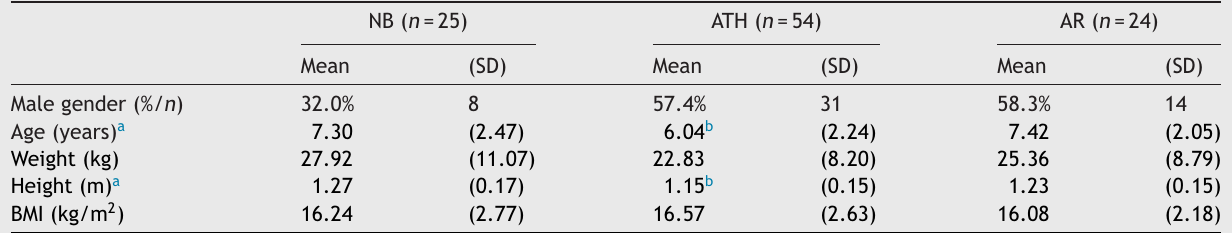
Demographic and anthropometric data.